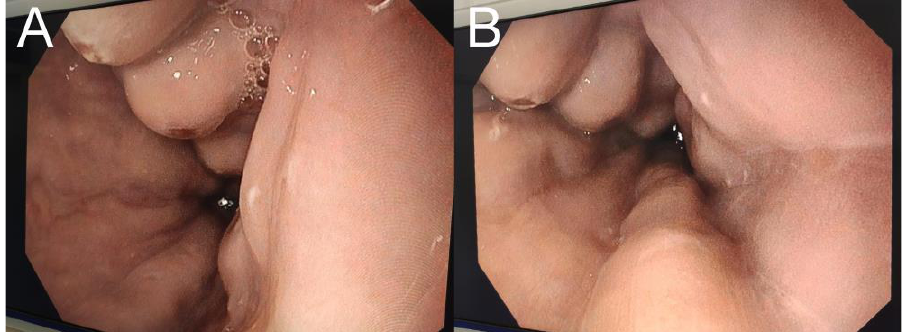
Figure 1. Upper endoscopy revealing grade two esophageal varices. ( A , B ) figures reveal tortuous, enlarged blood vessels that occupy less than one-third of the lumen of the esophagus. Some of the varices also present ulcerations.